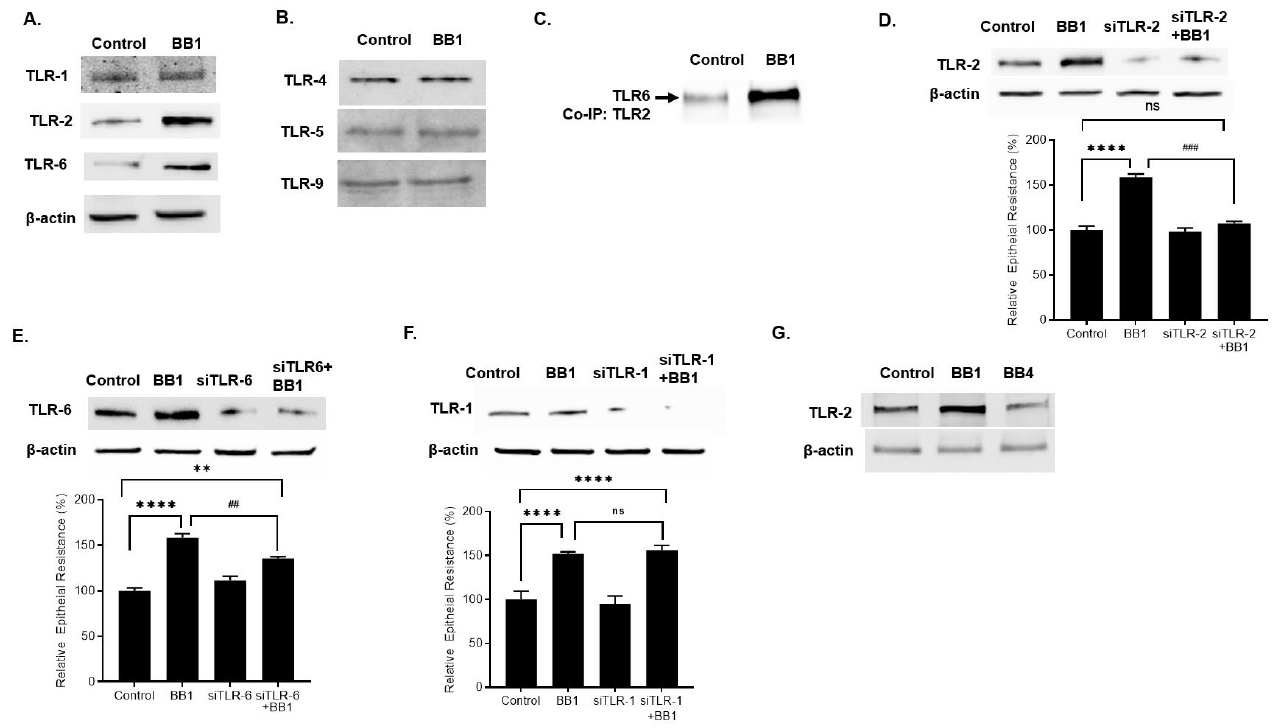
Figure 2. Effect of BB (1 × 10 8 CFU/mL) on Caco-2 TLRs. ( A ) BB1 caused an increase in Caco-2 TLR-2 and TLR-6 protein expression, but not TLR-1. ( B ) BB1 did not affect the protein expression of Caco-2 TLR-4, TLR-5, or TLR-9. ( C ) BB1 caused an increase in TLR-2/TLR6 interaction in Caco-2 monolayers. Total cell extracts were prepared and subjected to co- immunoprecipitation (co-IP) as described in Materials and Methods. ( D ) TLR-2 siRNA transfection caused a near-complete depletion of TLR-2 protein expression, prevented the BB1 induced increase in TLR-2 protein expression, and prevented the BB1-induced increase in Caco-2 TER (24-h experimental period); **** p < 0.0001 vs. control; ### p < 0.001 vs. BB1. ( E ) The siRNA induced knock-down of TLR-6 caused inhibition of BB1 induced increase in Caco-2 TER. ** p < 0.01 vs. control; **** p < 0.0001 vs. control; ## p < 0.01 vs. BB1; ns: not significant. ( F ) Knocking-down TLR-1 by siRNA transfection did not prevent the BB1 increase in Caco-2 TER; **** p < 0.0001 vs. control. ( G ) BB1 but not BB4 caused an increase in TLR-2 protein expression in Caco-2 monolayers (1-day experimental